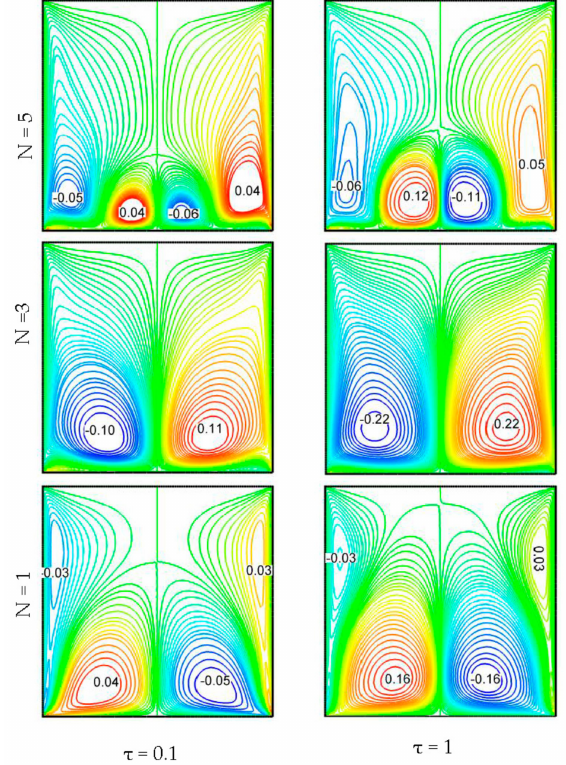
Figure 5. Influence of the odd values of N on streamlines for the selected values of τ with Gr = 10 6 . The influence of the even frequencies N (=2, 4, 6) on streamlines at Gr = 10 6 for some values of τ is displayed in Figure 6. For N = 2 and τ = 0.1, a most important rotating vortex is created near the bottom surface which covers almost the major space of the domain; it has a stream function value of 0.20 and a negative sense of rotation. Two very smaller vortices are found at the left corner of the bottom wall and at the top of the right vertical wall. At N = 4 and τ = 0.1, there are four cells having an opposite sense of rotation. However, in the case of N = 6, a mighty convective current outline is produced. Six vortices are created, among which five are in the vicinity of the sinusoidal heated base surface and have low to moderate strength. It is without a doubt observed that the convective streams are all the more connecting to the base-heated wall for an observable reason and that is that from this wall heat stream is approaching into the fluid. By and large, a decent convective attribute appears by the stream at N = 6 and τ = 0.1. However, for τ = 1 and N = 2, there are two cells rather than three, and the ruling cells in the center have an inverse feeling of turn. The commanding cell is at the center of the square walled-in area, has a stream function estimation of –0.91, and is turning in a clockwise way; however, for N = 4 and τ = 1, there are four cells that have an inverse feeling of rotation. Then again, if there should arise an occurrence of N = 6 and τ = 1, an amazingly strong convective current sample is generated. In this case, six cells are framed, where three are in the proximity of the sinusoidal heated base surface with low to moderate